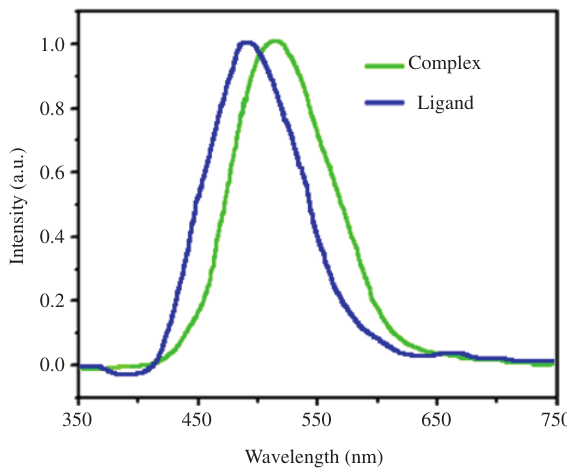
Figure 5: The photoluminescence spectra of complex 1 and free HL ligand.